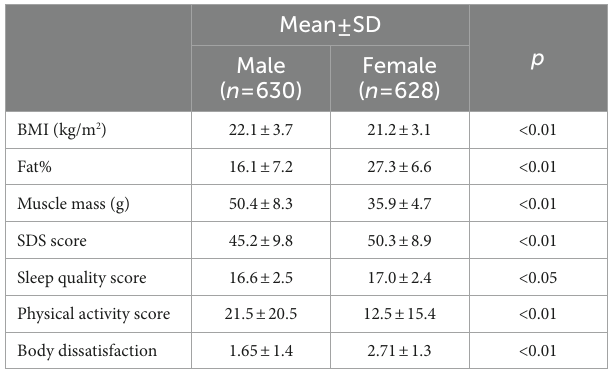
TABLE 1 Sample characteristics ( n =